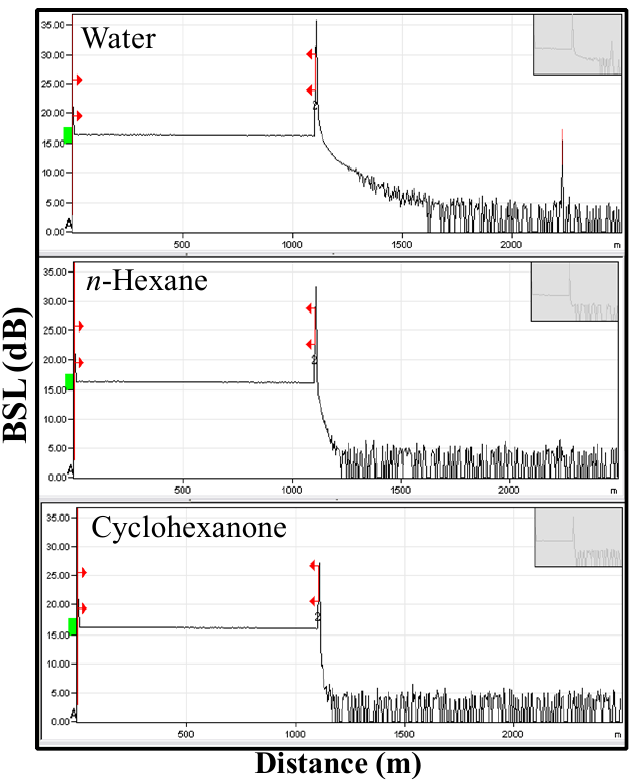
Figure 3. The output OTDR traces when the measured samples are water, n -hexane and cyclohexanone, respectively, at 1,100 m long